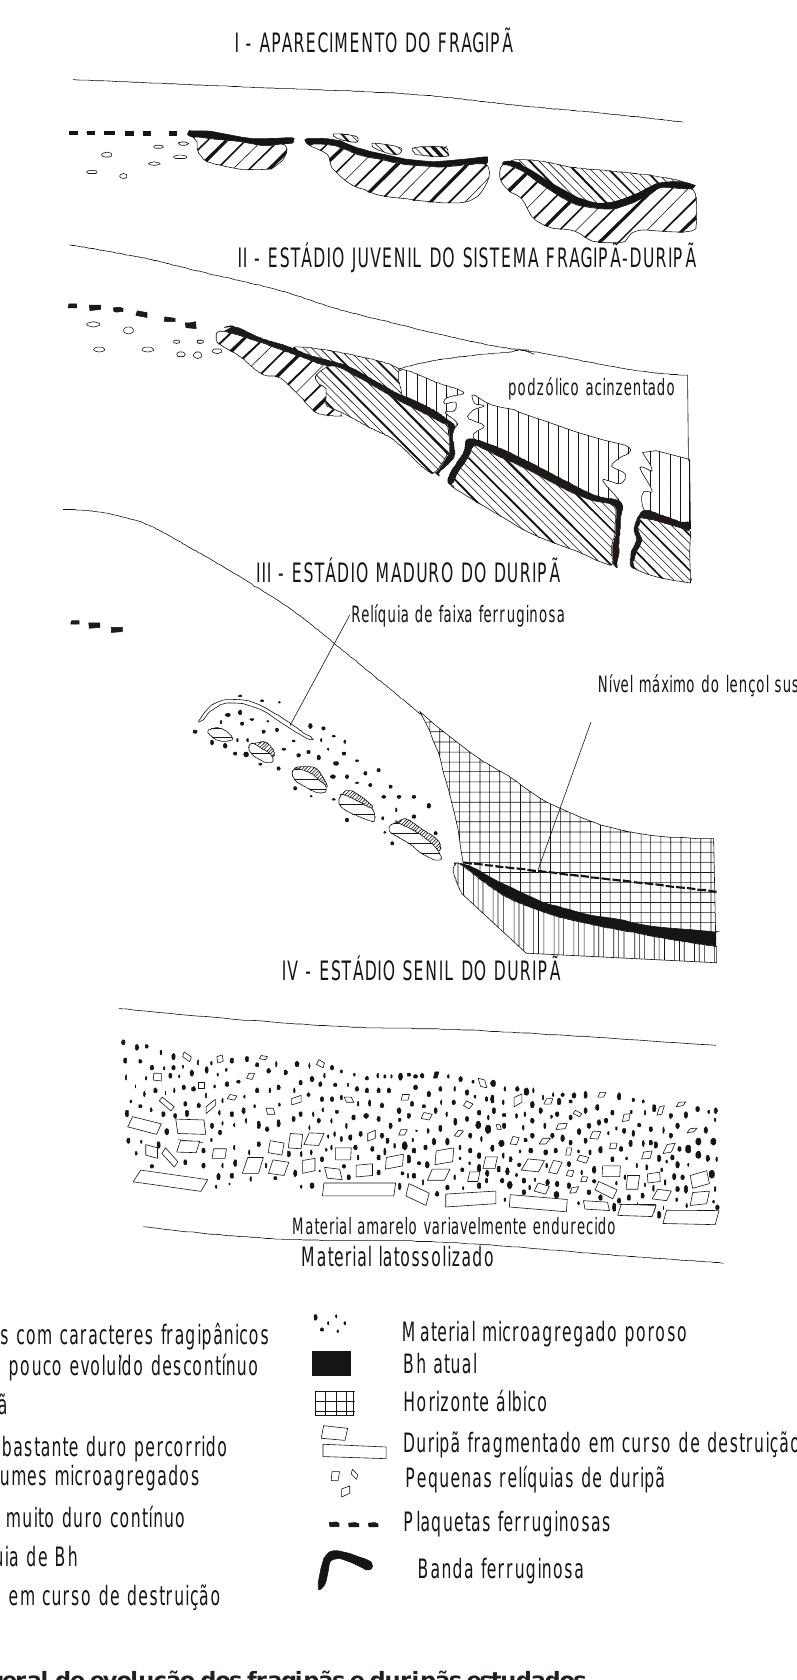
Figura 8. Esquema geral de evolução dos fragipãs e duripãs